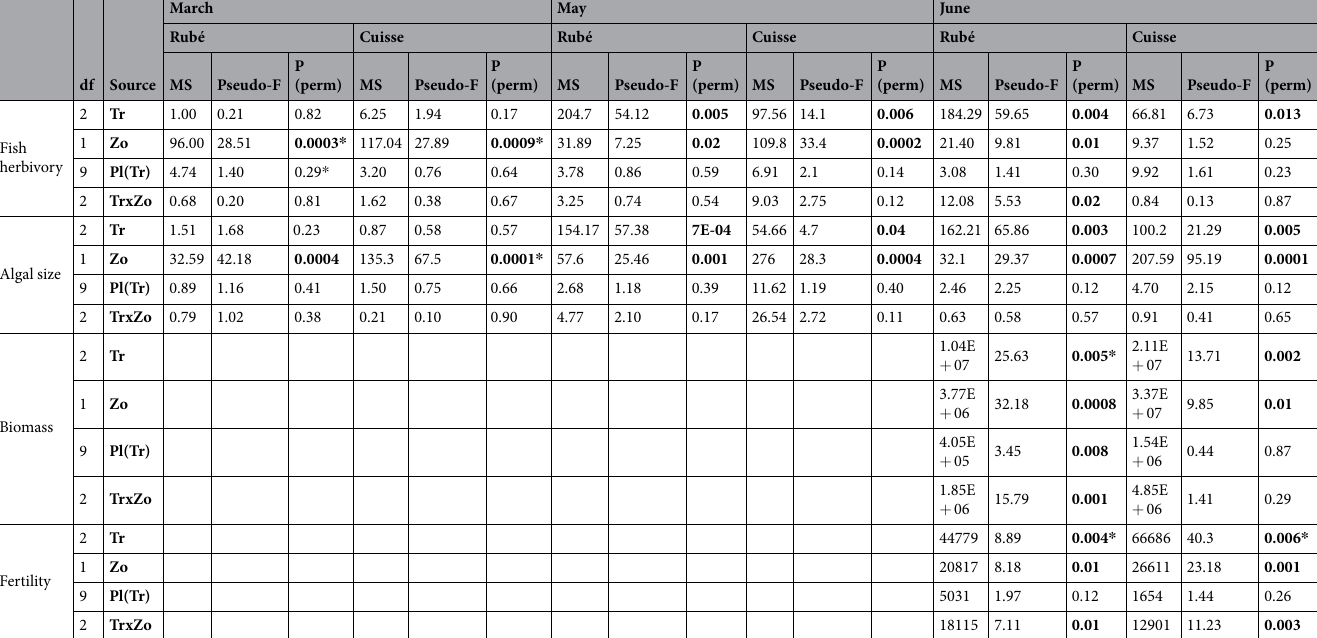
Table 1. Tables of PERMANOVA calculated on the different parameters: fish herbivory (as number of bites/12.5 cm 2 ), algal size (as mean maximum length in cm), biomass (in g/12.5 cm 2 ) and fertility (as number of receptacles per 12.5 cm 2 ), for both sites and in the different months. Tr: Treatment, Zo: Zone, Pl: plots. Statistically significant values are in bold type. Asterisks indicate that PERMDISP tests were significant (see Supplementary